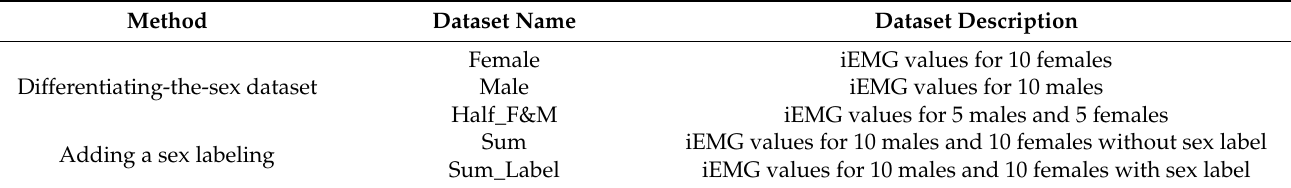
Table 2. The optimal configurations of k-NN, SVM and ANN classifiers applied to different datasets identified by the training set are shown in Tables 3 and 4. Table 2. The dataset descriptions.